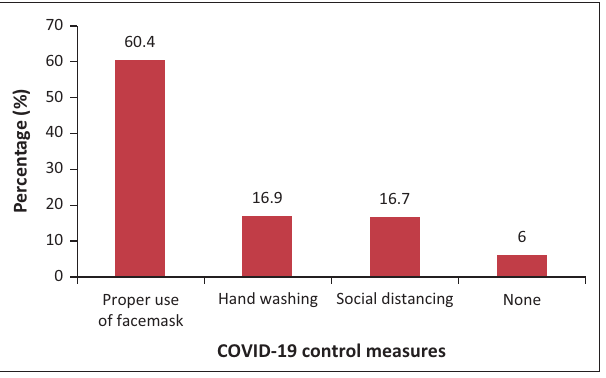
FIGURE 1: COVID-19 control measures mostly practised by the frontline healthcare workers in Ethiopia,